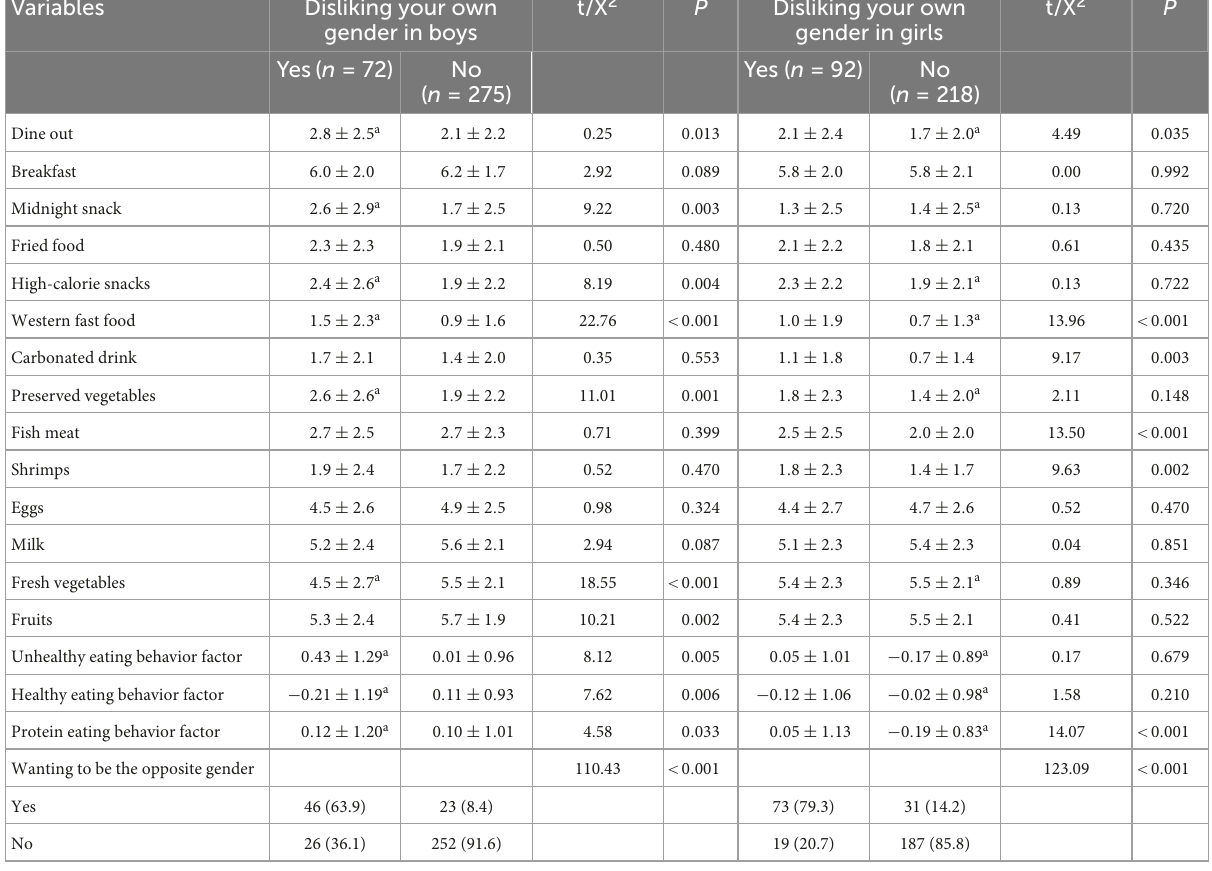
TABLE 4 Comparisons of differences in eating behaviors between children and adolescents with disliking their own gender and liking their own gender. Variables Disliking your own t/X 2 P Disliking your own gender in boys gender in